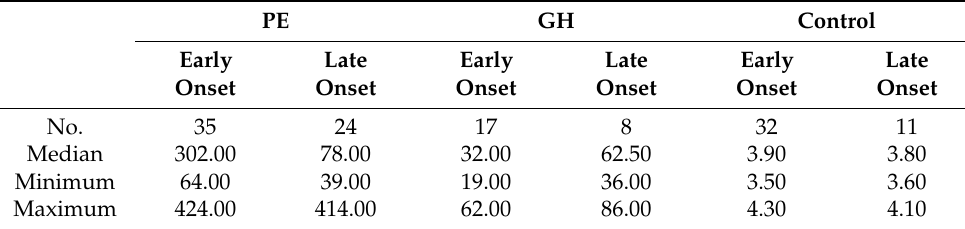
Minimum Maximum